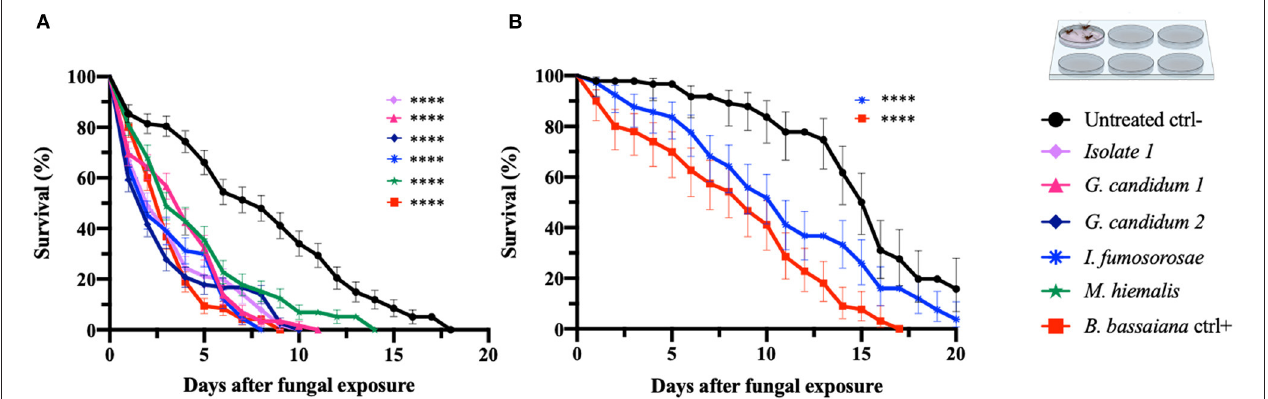
FIGURE 2 | Spore-dipping assays of An. gambiae and Ae. aegypti mosquitoes. Mosquitoes were exposed via a dipping assay to a spore solution (10 8 spores/ml) for 1min, and the mosquito survival was monitored for 20 days. Data are here presented for An. gambiae (A) and Ae. aegypti (B) . The fungal species tested on each mosquito species were the ones identified as active in the respective direct-exposure experiment. The graphs represent the average and standard deviation of three biological replicates, N = 30 females per replicate. As a negative control, mosquitoes were exposed to a spore-free solution, and as a positive control they were exposed to a spore solution of B. bassiana . The statistical significance of the results for each fungus was compared to the negative control and analyzed by log rank-Mantel-Cox test; p -values are presented in Table 3 . * p < 0.05, ** p < 0.01, *** p < 0.001, **** p <